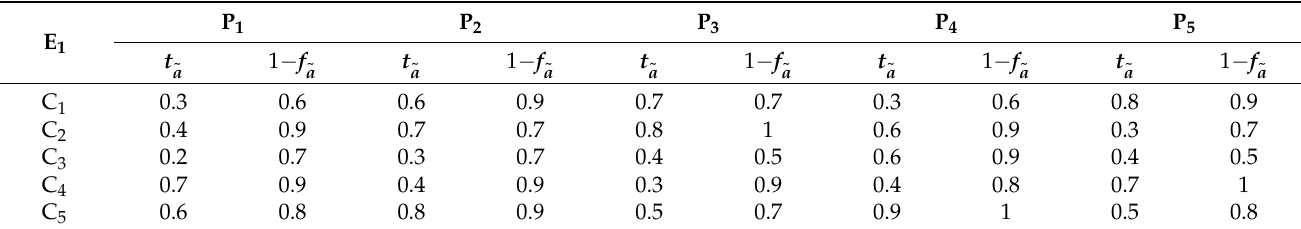
Table 14. Expert 1’s assessments on the different patients’ status.